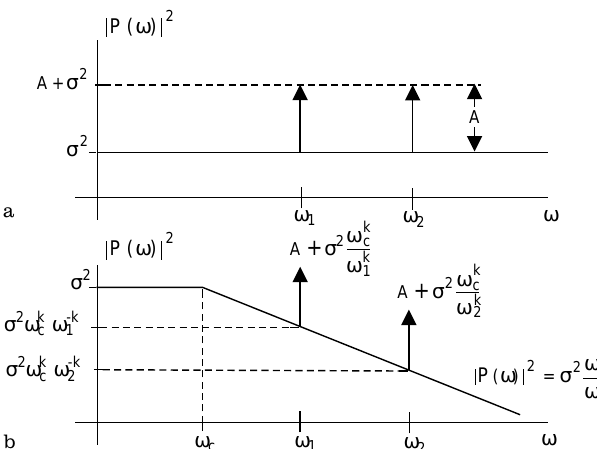
Fig. 3a, b. An example of the overestimation of tidal amplitudes which may result due to the underlying geophysical noise floor. The results are shown for a white noise and b colored noise